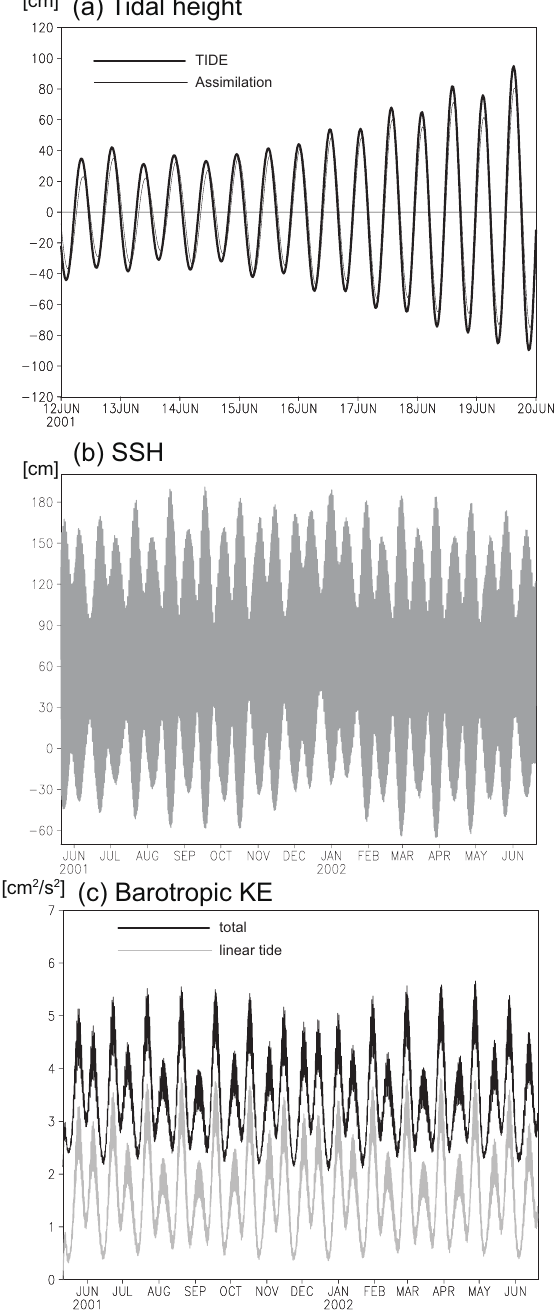
Fig. 6. (a) Same as Fig. 4, but for 12–20 June 2001 (day 32–40). The thick and thin lines indicate TIDE and assimilation analysis, respectively. (b) The variation range of SSH at the site (180 ◦ E, 0 ◦ N) over one year – from 21 May 2001 to 20 June 2002 (day 10–405) – in TIDE. (c) Same as (b) but for the volume-averaged barotropic kinetic energy [cm 2 s − 2 ] of U (BKE, black) and U lt (BKE lt ,gray).